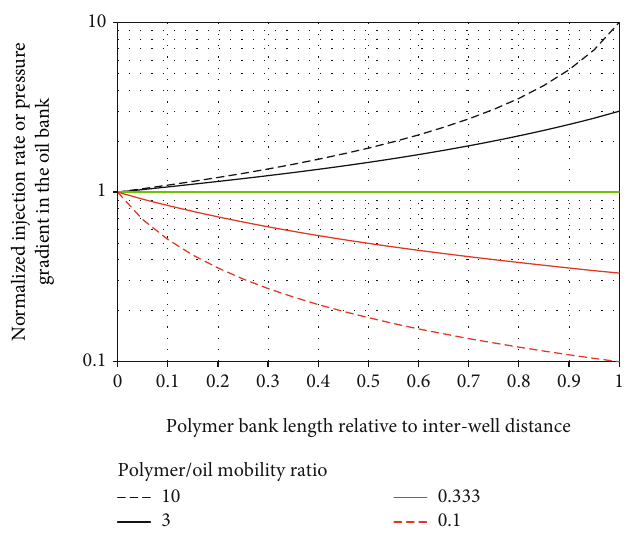
Figure 3: Normalized injection rate or pressure gradient in the oil bank versus polymer/oil mobility ratio and polymer bank